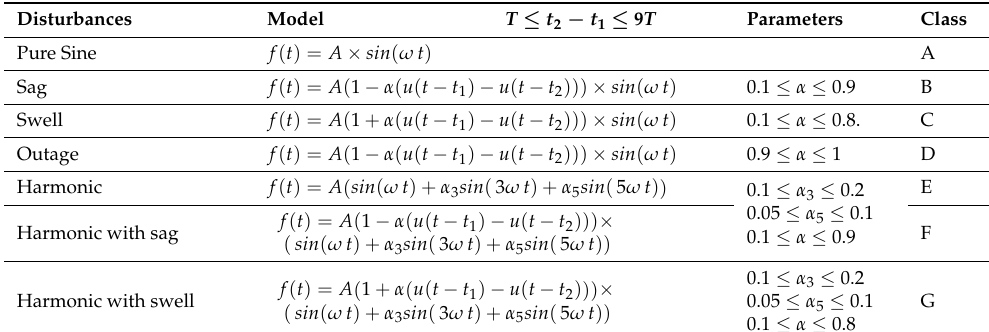
Table 1. The power quality (PQ) disturbances and its